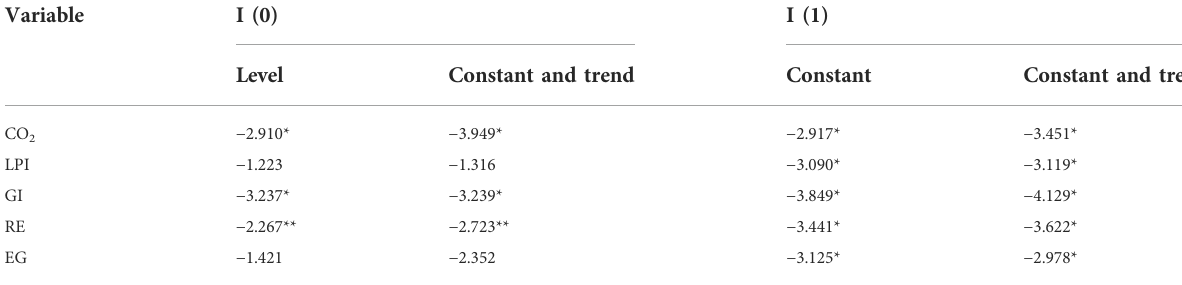
TABLE 5 CIPS unit root test